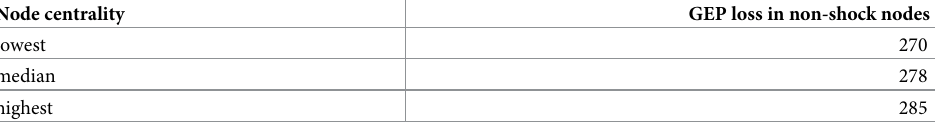
Table 4. The Global Equilibrium Population (GEP, the average population of the nodes in the networks after equi- librium) loss after a shock is applied to a node with low, median or high centrality in the 10 node network. The increase in population in the shock node is deducted from this. The population loss in the rest of the network is larger when the shock is applied to a node with a higher